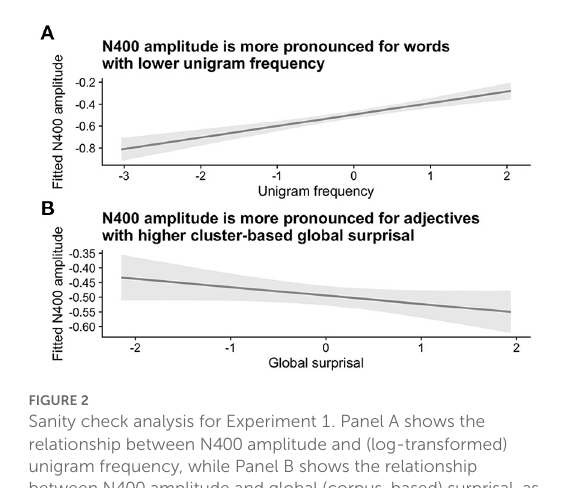
FIGURE2 Sanity check analysis for Experiment 1. Panel A shows the relationship between N400 amplitude and (log-transformed) unigram frequency, while Panel B shows the relationship between N400 amplitude and global (corpus-based) surprisal, as defined using bigrams at the adjective cluster level. Both unigram frequency and surprisal values were z-transformed. Shaded areas indicate 95% confidence intervals.